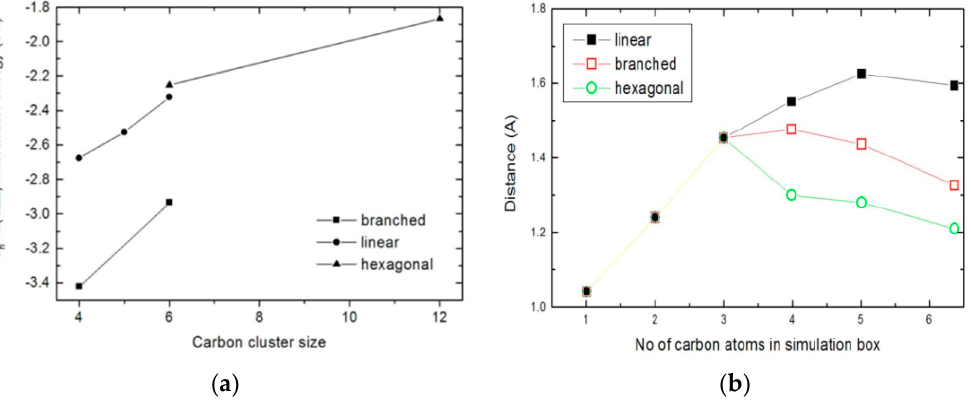
Figure 3. Dependence of the binding energy of a growing carbon cluster on local geometry ( a ) and the dependence of the variation in the separation distance between the nucleated carbon cluster and the Ni(322) step surface on number of carbons in the cluster ( b ).